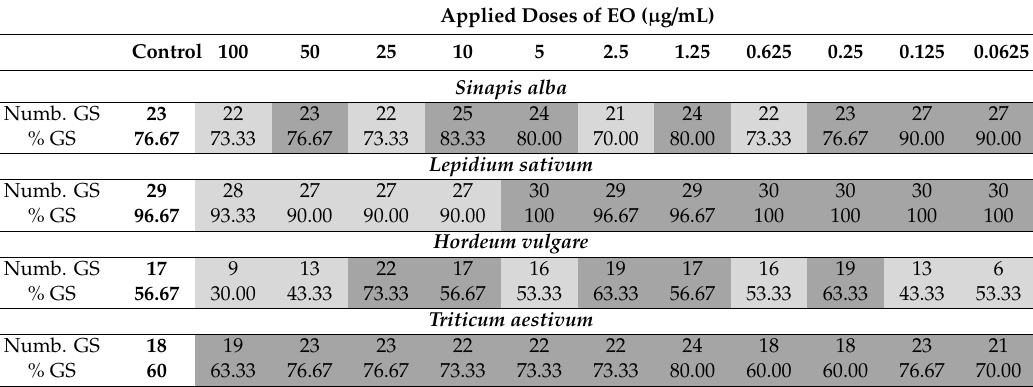
Table 2. Total number and % of germinated seed of model organisms in comparison to control after exposition to particular doses of Origanum vulgare